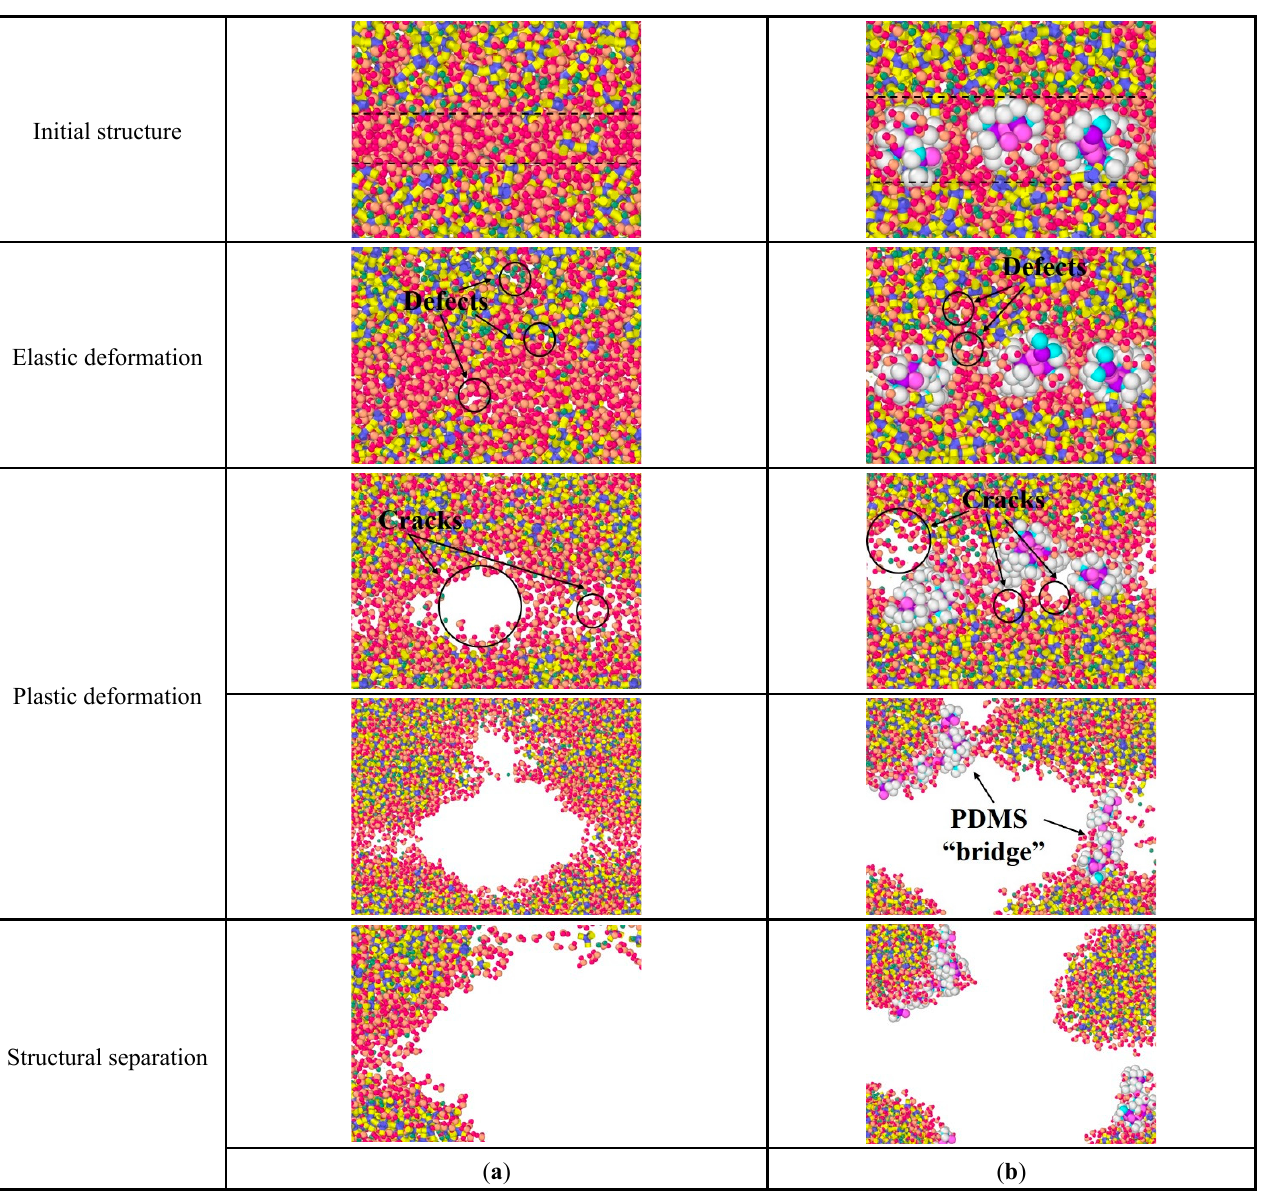
Figure 11. Structural changes of C-S-H stretching along the y -axis: ( a ) pure C-S-H; ( b ) PDMS- modified C-S-H.